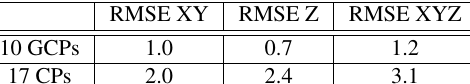
Table 1. Photogrammetric RMSE [cm]